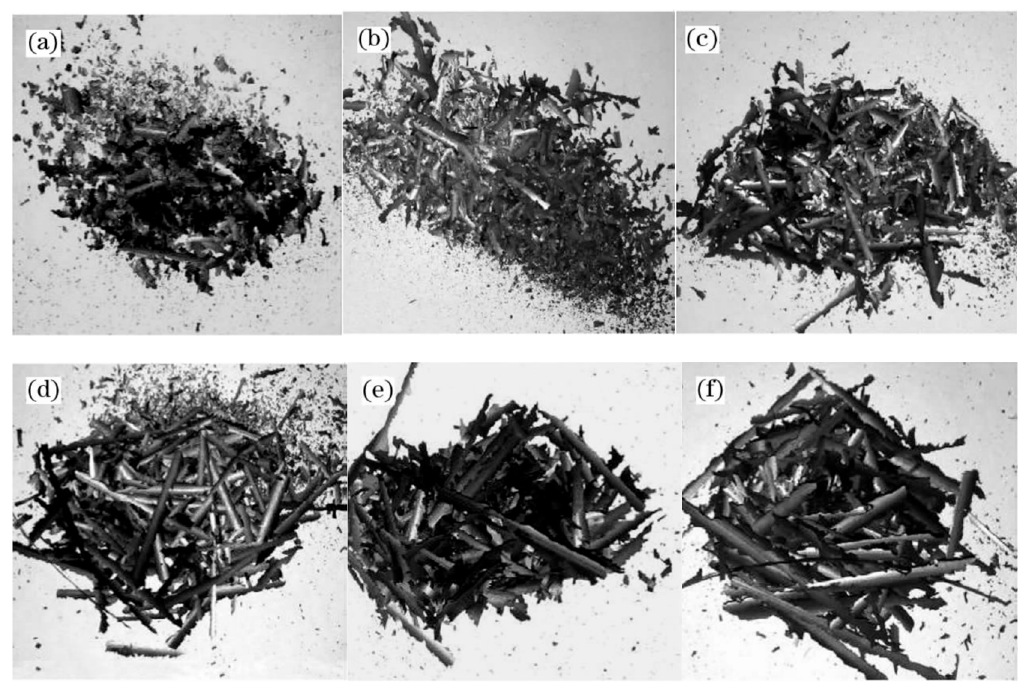
Figure 10. Morphology of the iron oxide scale on the surface of a steel cord wire rod under different spinning temperature treatments: ( a ) 870 °C, ( b ) 880 °C, ( c ) 890 °C, ( d ) 905 °C, ( e ) 910 °C, and ( f ) 925 °C. Reprinted with permission from ref. [16].